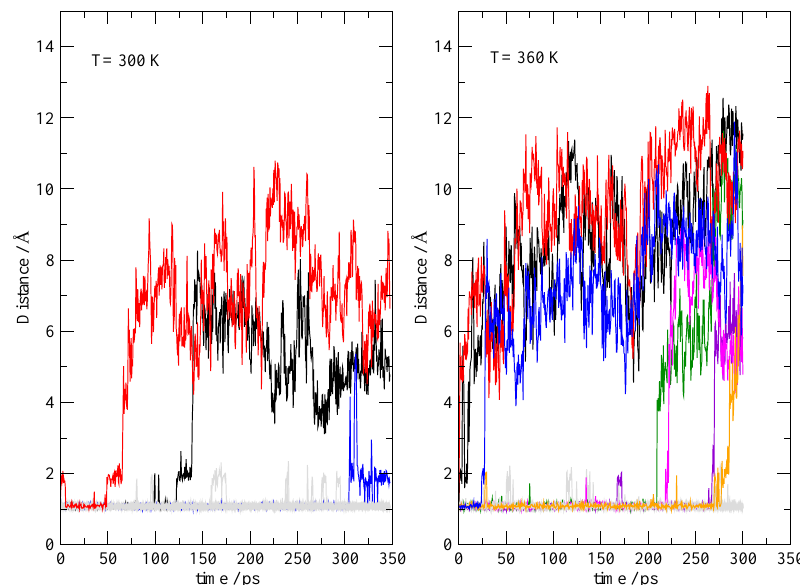
Figure 10. N–H distances in TEAH + during the simulations initially prepared as a completely ionized system ( I20:20 ). Distances were saved every 500 fs. The migrating protons are highlighted by different colors, while all the others are reported in gray.